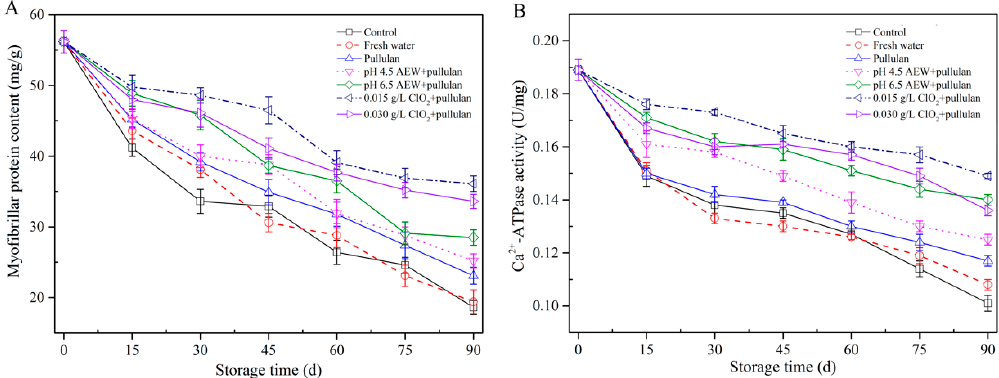
Figure 5. Myofibrillar protein content ( A ) and Ca 2+ -ATPase activity ( B ) of half-shell mussels treated with the control, water, and combined glazing solutions during 90 days of frozen storage.